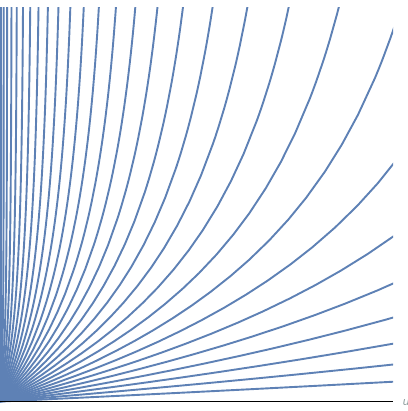
Figure 10 . Every line on the u plane corresponds to (cid:12)xed (cid:11) 1 and varying (cid:11) 2